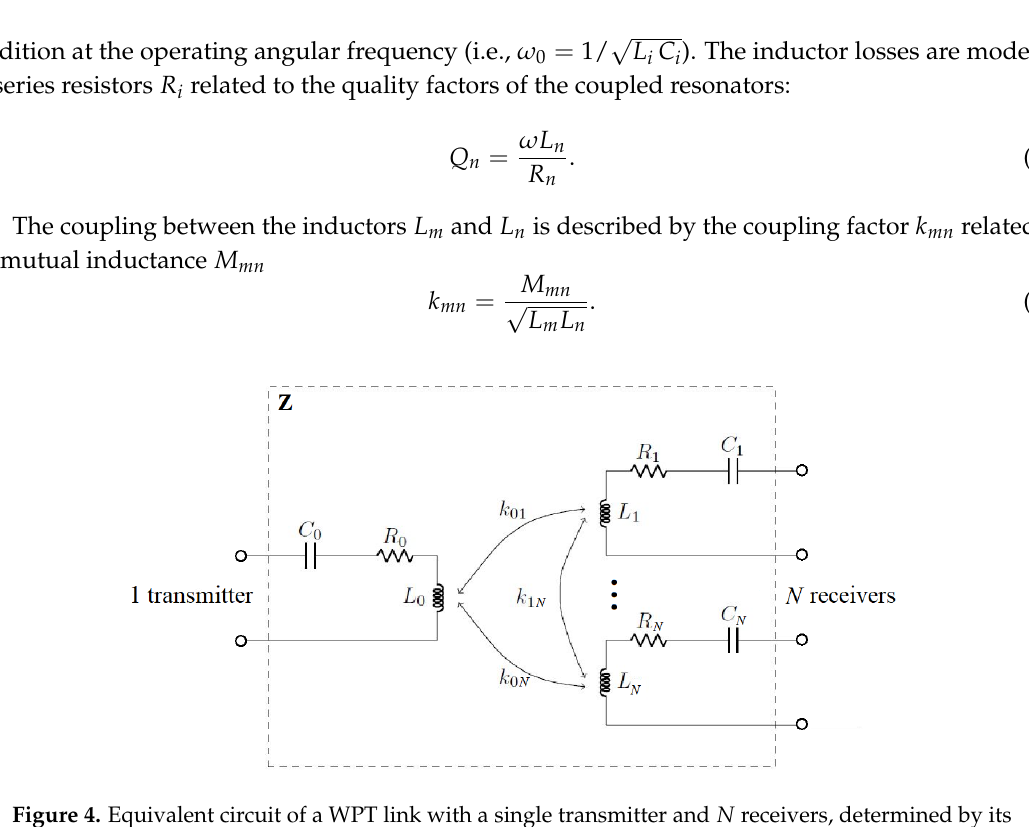
Figure 4. Equivalent circuit of a WPT link with a single transmitter and N receivers, determined by its impedance matrix Z